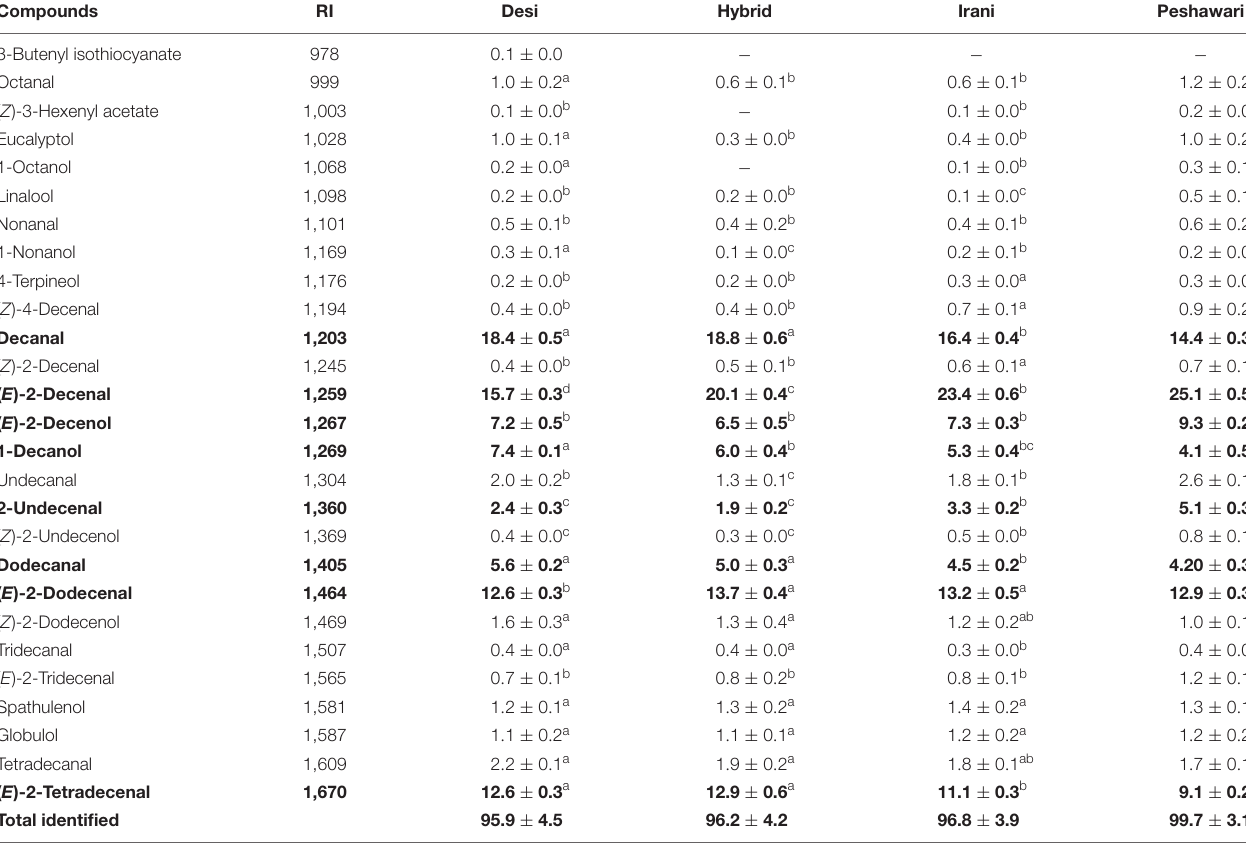
TABLE 3 | Percentage chemical composition of essential oils extracted from fresh coriander leaves of four cultivars through steam distillation. Compounds RI Desi Hybrid Irani Peshawari 3-Butenyl isothiocyanate